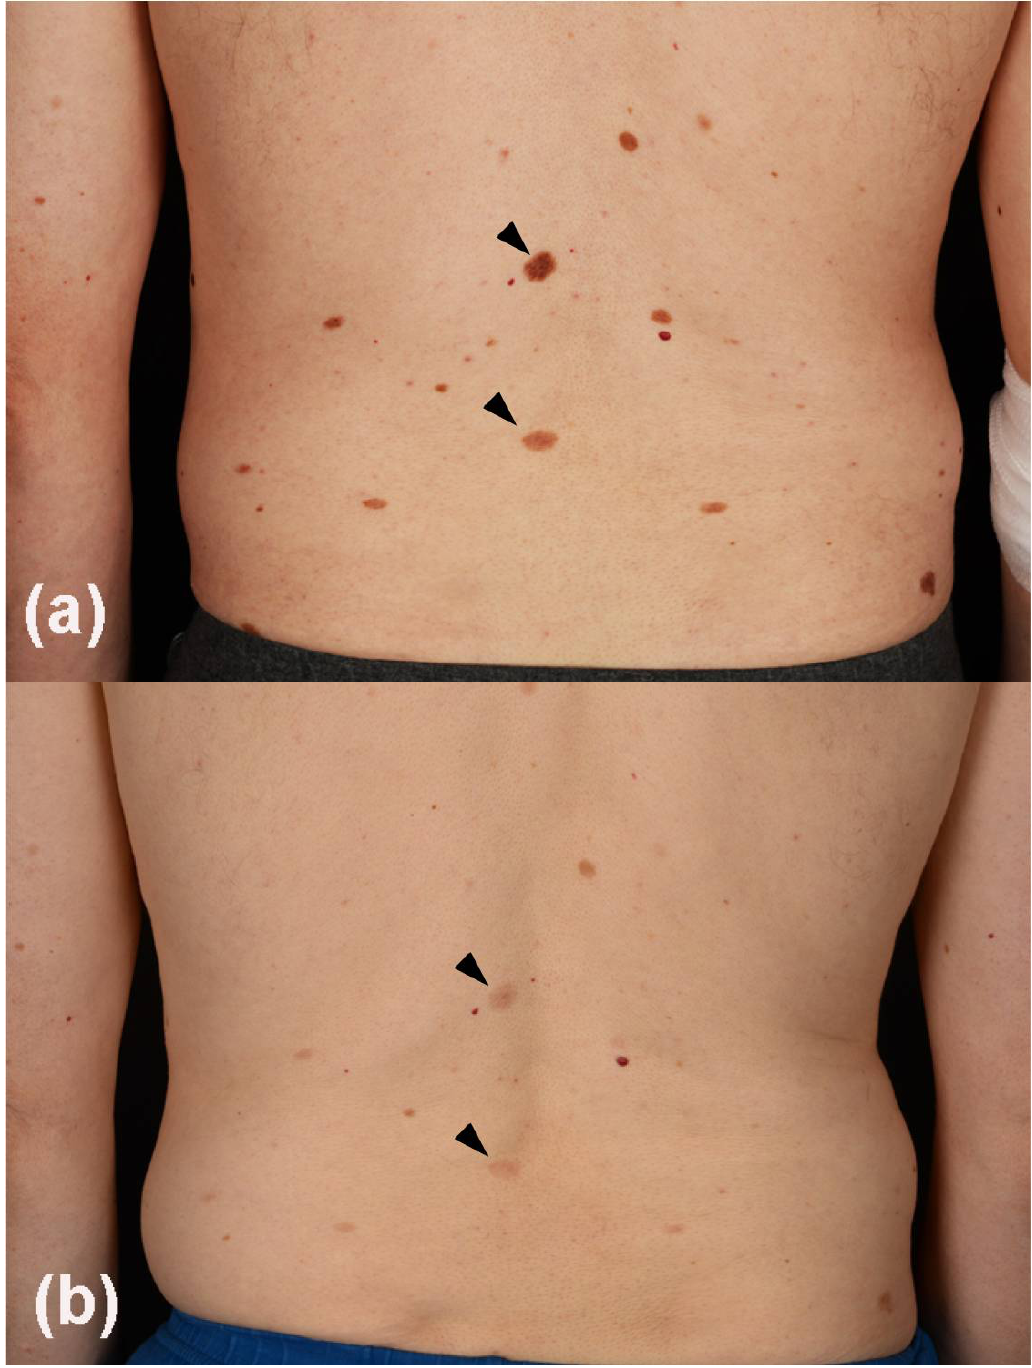
Figure 2. Showing a 59-year old male patient with metastatic melanoma and multiple benign melanocytic nevi on the back ( a ). After 4 cycles (3 months) of anti-PD-1 plus anti-CTLA-4 combination therapy, he developed marked nevi lightening ( b , highlighted by arrowheads).